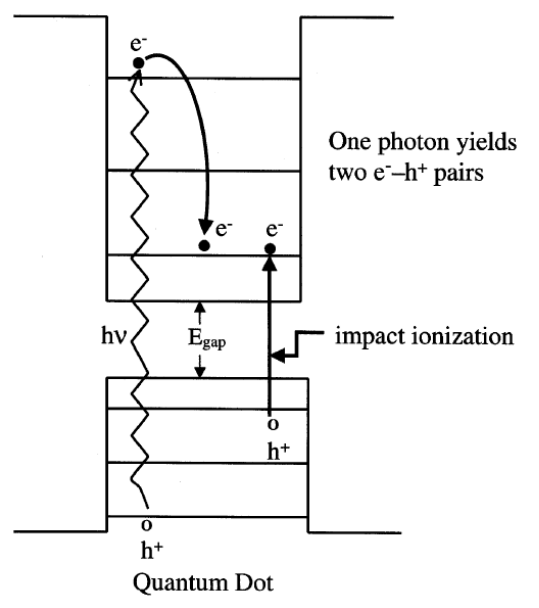
Figure 12. Schematic energy diagram for impact ionization generating two carrier pairs from each incident photon (reprinted from [63]; © 2002, with permission from